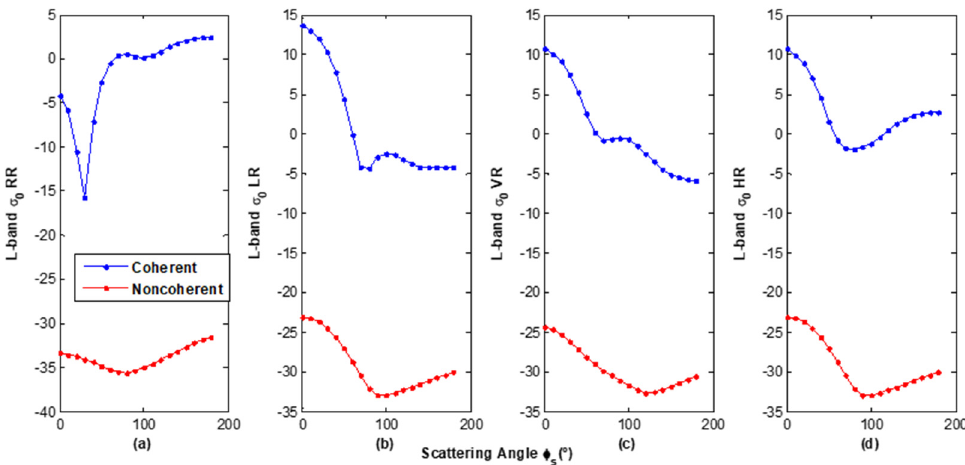
Figure 4. Comparison between coherent and incoherent scattering ( a ) RR polarization, ( b ) LR po- larization, ( c ) VR polarization, and ( d ) HR polarization.